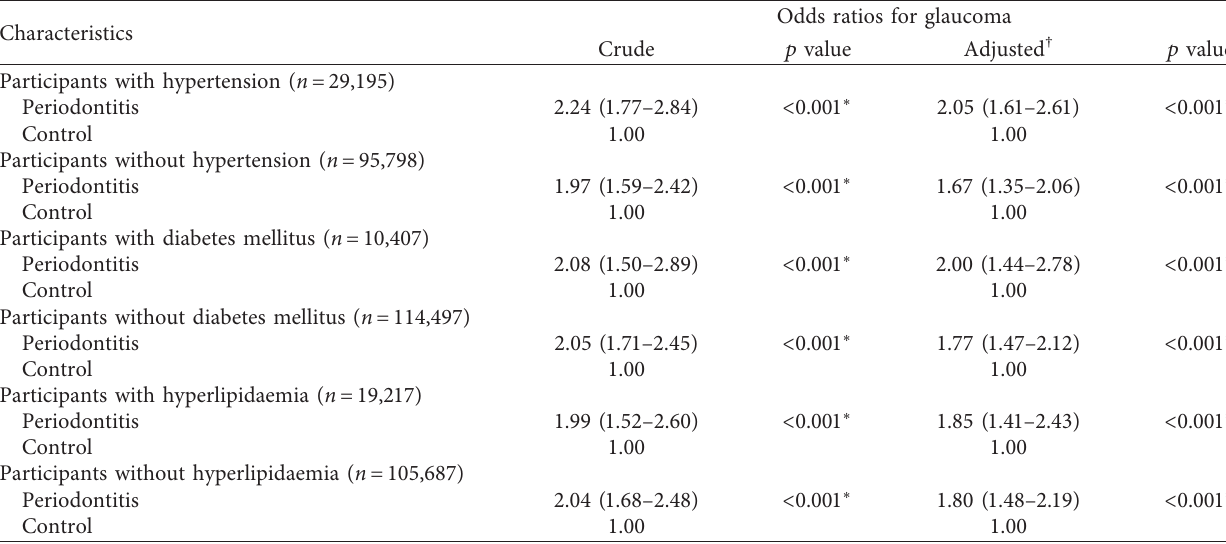
Table 3: Crude and adjusted odds ratios (95% confidence interval) of periodontitis as a risk factor for glaucoma according to their past medical histories of hypertension, diabetes mellitus, and hyperlipidaemia.